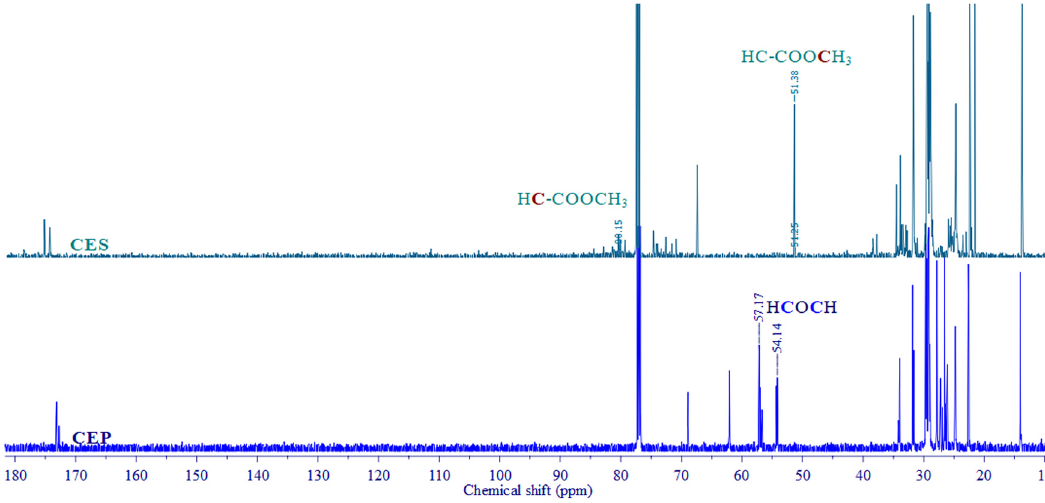
Figure 8: 13 C NMR spectra of CEP and CES